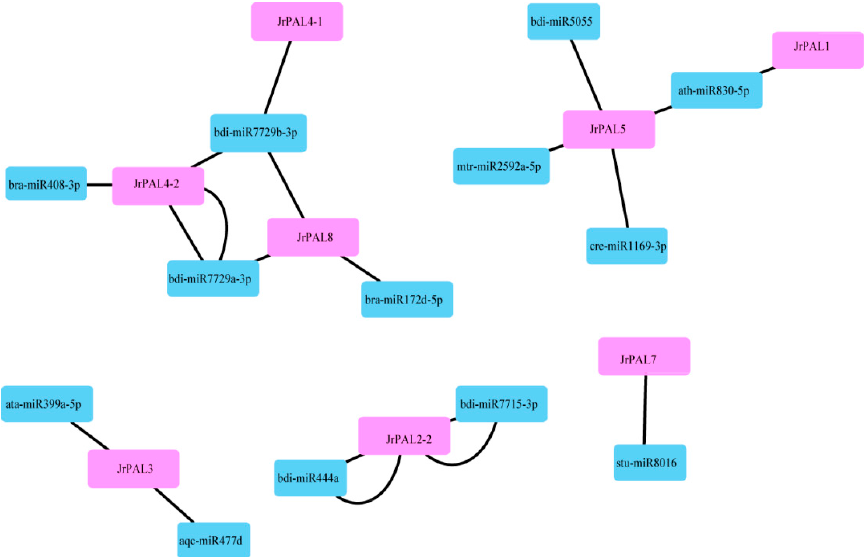
Figure 5. A schematic representation of the regulatory network relationships between the putative miRNAs and their targeted walnut PAL genes.